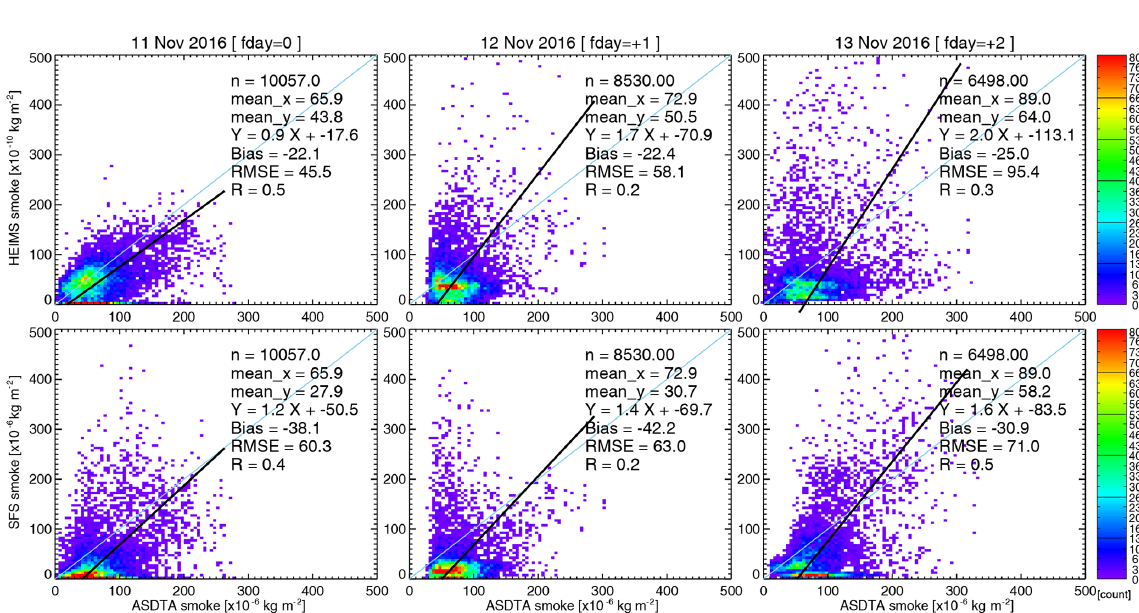
Figure 7. Scatterplot comparisons between ASDTA smoke and HEIMS smoke (top row) and ASDTA and SFS smoke (bottom row) for forecast days: fday = 0, + 1, +